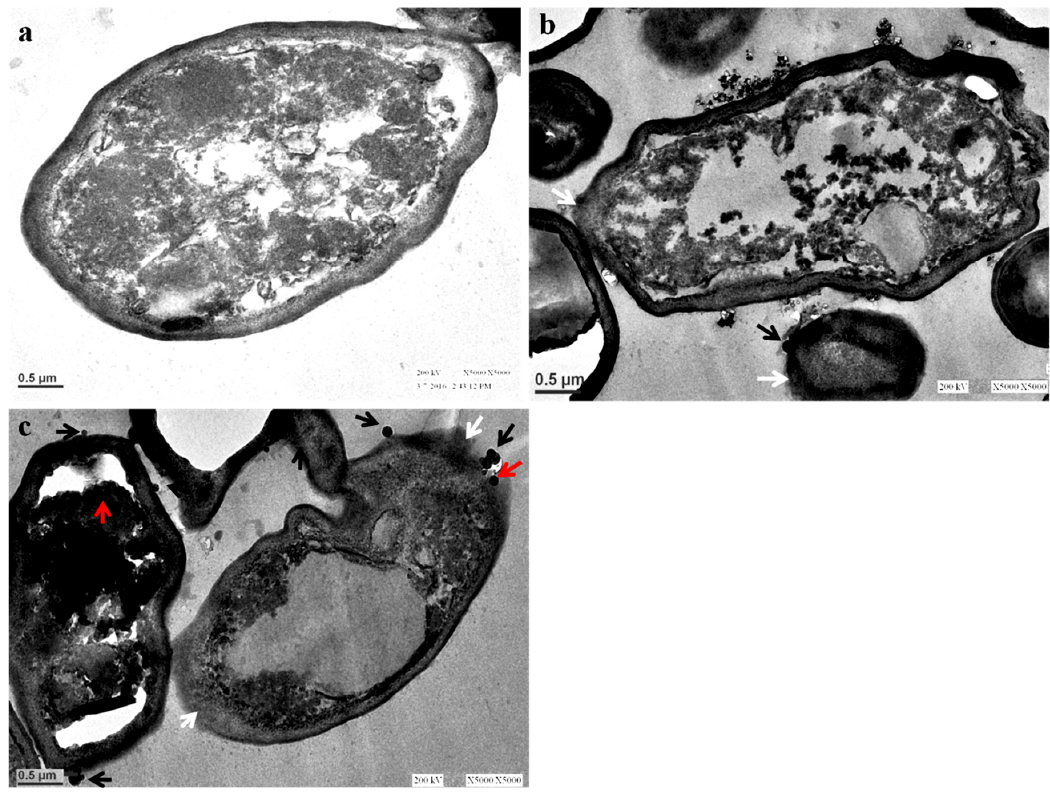
Figure 7. TEM images of C. albicans . ( a ) Untreated control cells; ( b , c ) Cells treated with 250 μ g/mL and 500 μ g/mL of AgNPs showing the attachment (black arrows) and penetration of AgNPs inside the cells (red arrows), degradation, destruction, and separation of the outer-most layers of the cell wall and cytoplasmic membrane (white arrows).